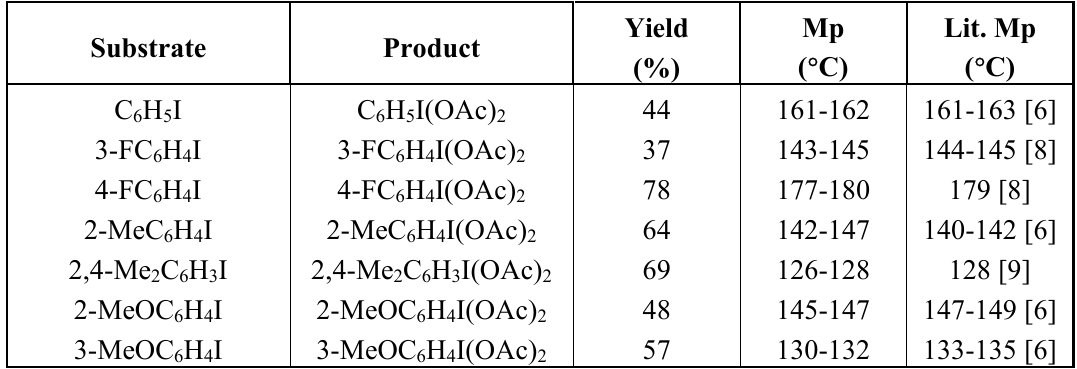
Table 1. Final yields and melting points (uncorrected) of the purified (diacetoxyiodo)- arenes obtained from the corresponding iodoarenes.